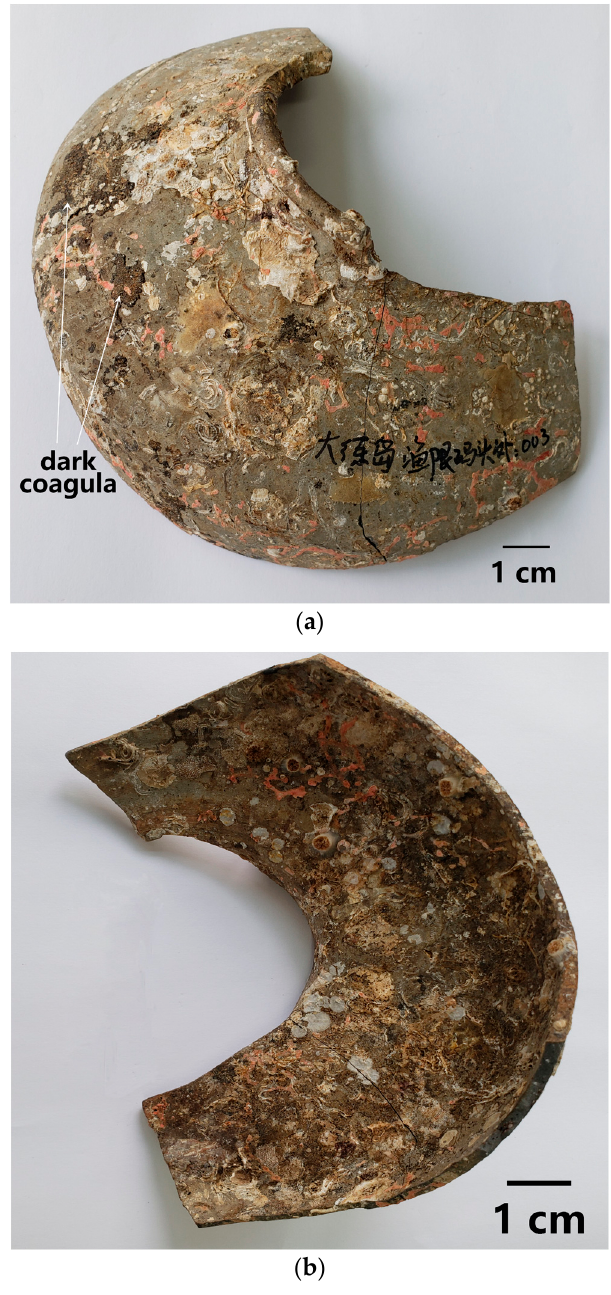
Figure 1. Appearance of the sauce-glazed shard DL of the Song Dynasty salvaged out of water at the Dalian Island Wharf: ( a ) outer surface, showing serious glaze spalling, dark coagula, and various marine animal remains; ( b ) inner surface, showing contamination and various marine animal remains. Chinese in ( a ): out of the Dalian Island Yuxian Wharf: 003.